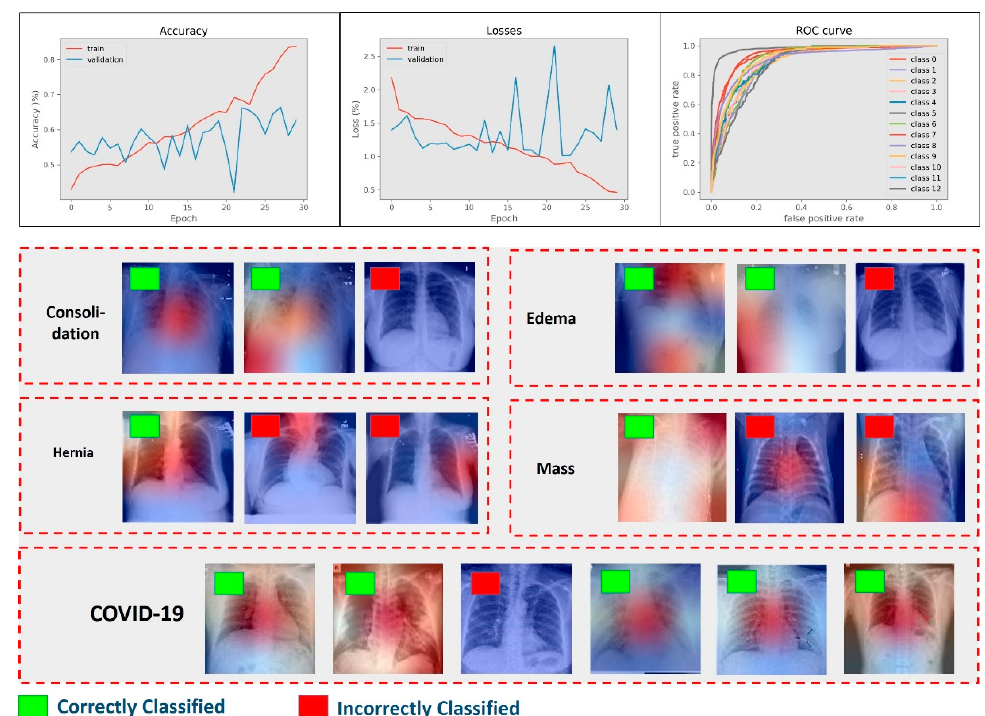
Figure 5. Visualized results for the abnormality discrimination. Train-validation accuracy and loss over the training epochs and AUC scores for the classes are presented in the top graph. Selected output images of the Grad-CAM implementation are visualized. Each dashed-line box presents a true class, while the green and red boxes distinguish between correctly classified samples and mistakes, respectively.